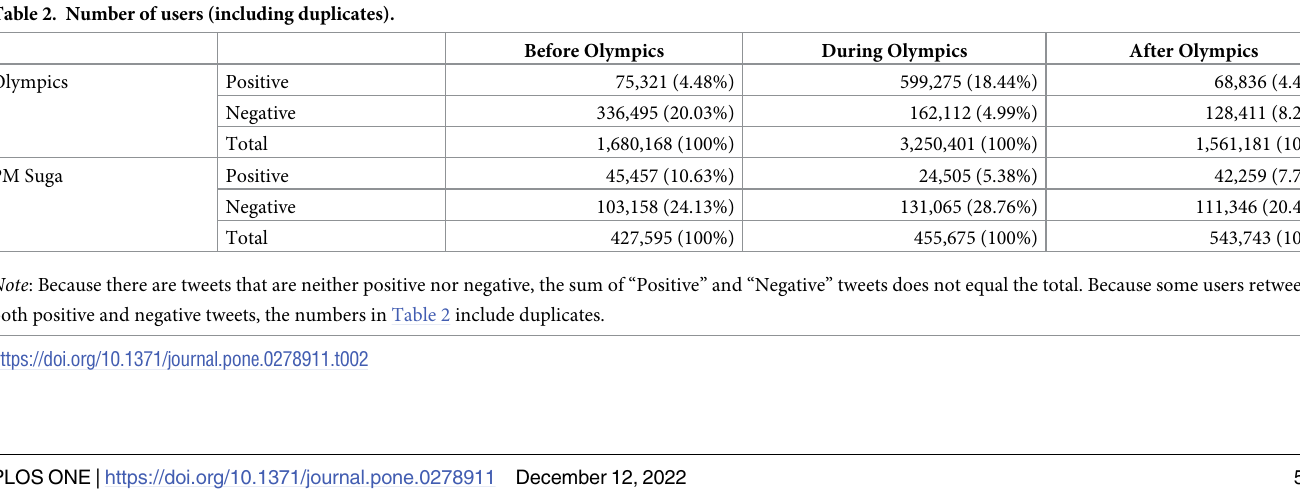
First, based on the numbers in Table 2, Fig 1 plots the number of users who retweeted posi- tive/negative tweets about the Olympic Games during each period (see the Methods section for an explanation of how Table 2 was created). Before the start of the Games, the number of accounts posting negative retweets accounted for 20.0% in the entire period (336,495/ 1,680,168), but during the Games this decreased to 4.9% (162,112/3,250,401). On the other hand, the number of accounts posting positive retweets increased from 4.5% (75,321/ 1,680,168) before the Games to 18.4% (599,275/3,250,401) during the Games. These results indicate that the overall negative reactions before the start of the Games improved significantly after they started. The strength of our data lies not only in showing these overarching trends but also in the ability to track changes in attitude toward the Games within each user. In the following analy- sis, “P” refers to accounts that have retweeted positive tweets about the Olympic Games, “N” refers to accounts that have retweeted negative tweets, and “–” refers to accounts that have retweeted tweets that are Games-related but neither positive nor negative. Based on these clas- sifications, we denote accounts that changed cluster affiliation from negative to positive from before to during the Olympic Games as “NP,” accounts that remained negative as “NN,” accounts that changed from positive to negative as “PN,” and accounts that remained positive as “PP.” We also denote accounts that retweeted positive tweets beforehand but did not retweet positive or negative tweets during the Olympic Games as “P–.” Furthermore, to capture attitu- dinal changes clearly, accounts that posted both positive and negative tweets during the same period were excluded from the analysis. The results of this categorization of attitudinal changes at the user level from before to during the Games are shown in Table 3. As indicated by the number of accounts labeled “NP,” 71,944 users, or 23% of the 336,495 users (see Table 2) who expressed negative sentiments beforehand came to show positive atti- tudes during the Games. On the other hand, among the users who showed positive attitudes before the opening ceremony, only 414 showed a negative attitude after the Games opened.